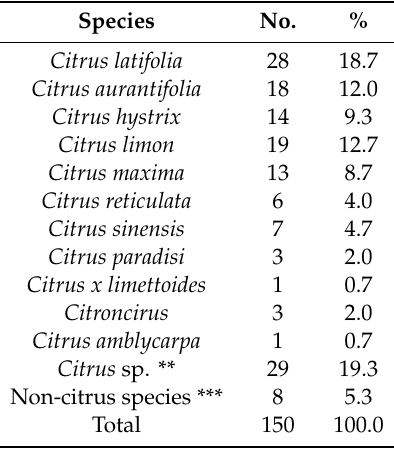
Table 2. X. citri interceptions for main Rutaceae around the world (2006–2018)*.